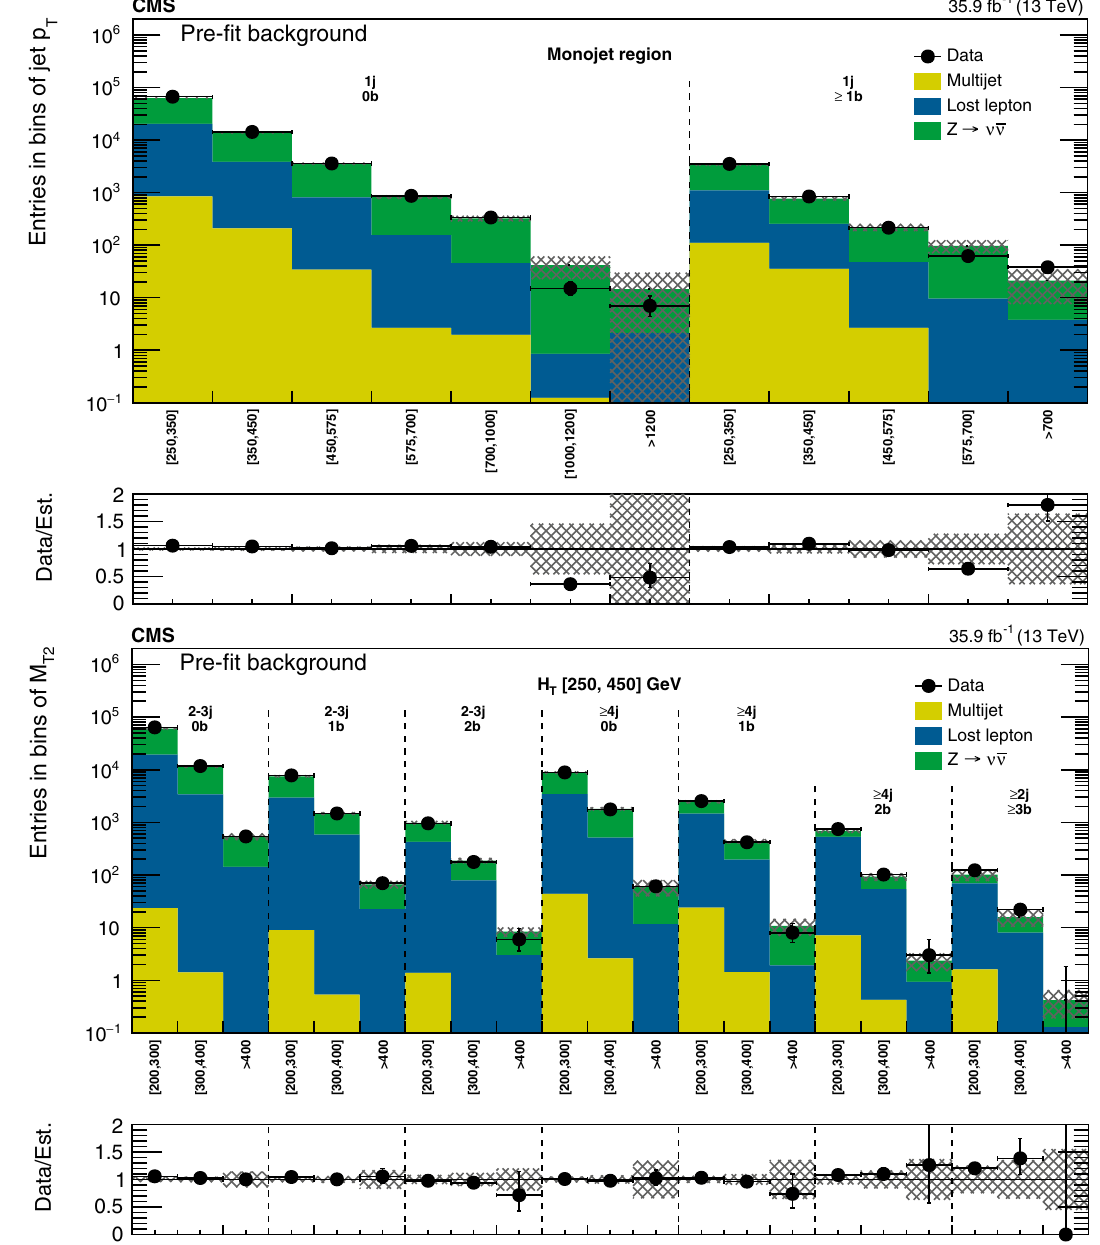
Fig. 9 (Upper)Comparisonoftheestimatedbackgroundandobserved data events in each signal bin in the monojet region. On the x -axis, the p jet1 binning is shown in units of GeV. Hatched bands represent the full T